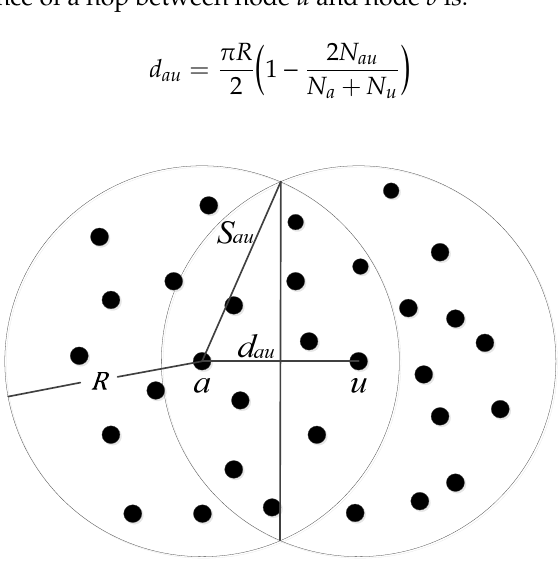
Figure 3. Schematic diagram of calculating the distance between neighbor nodes.